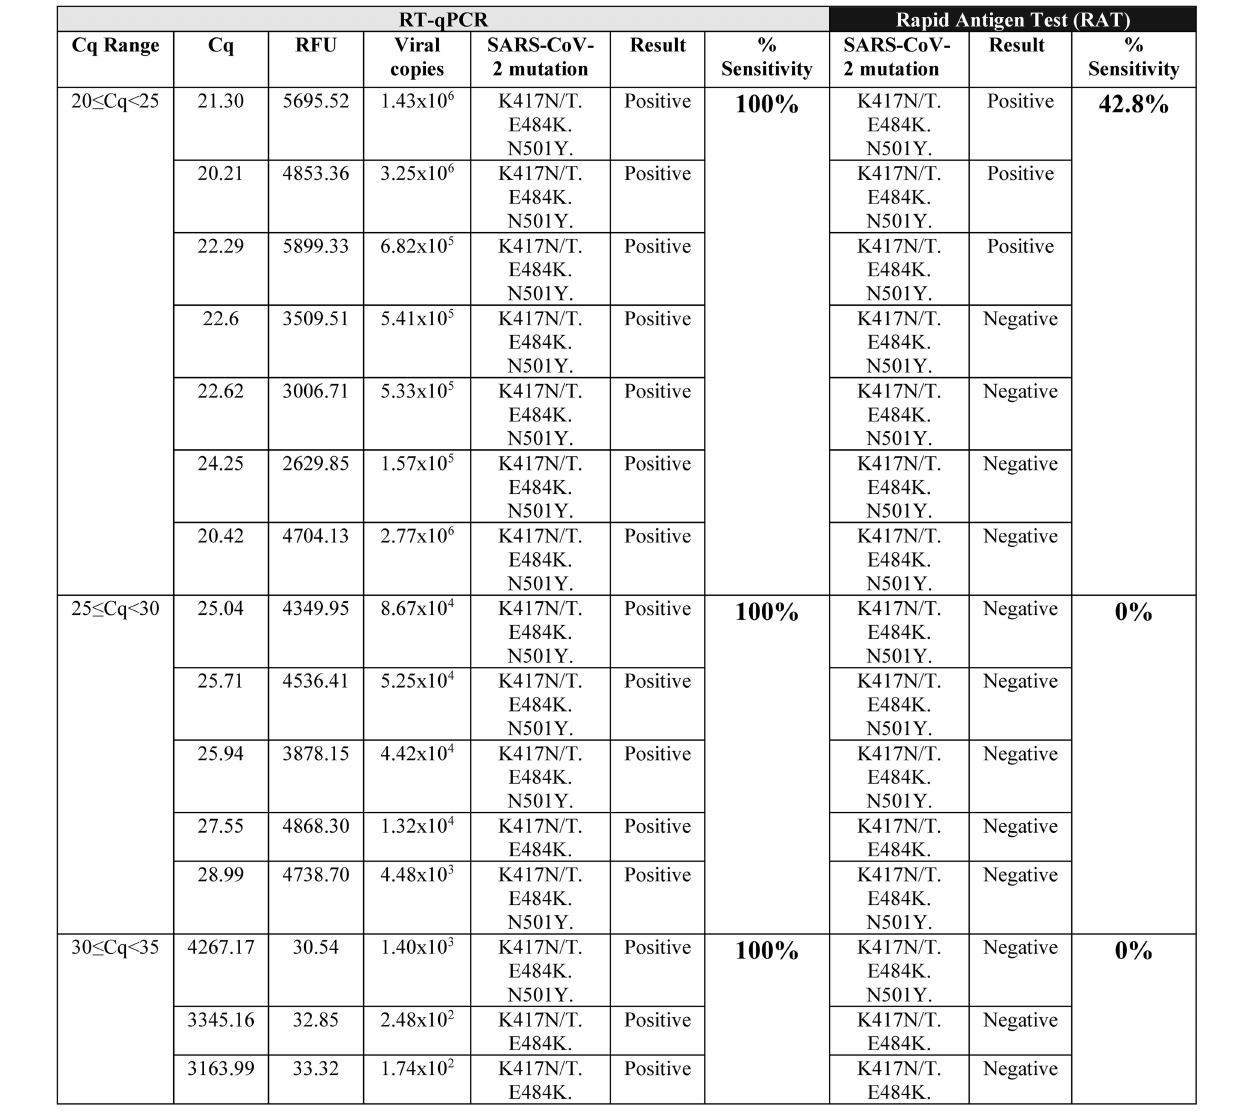
Band intensity in RAT 0